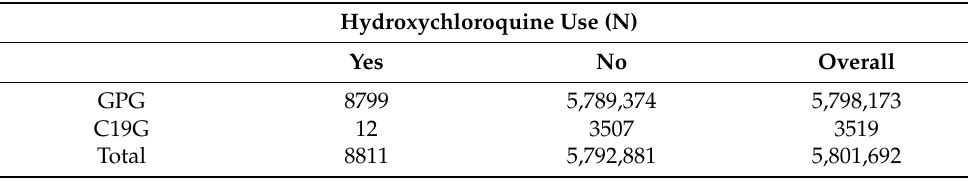
Table 1. Baseline characteristics of the study